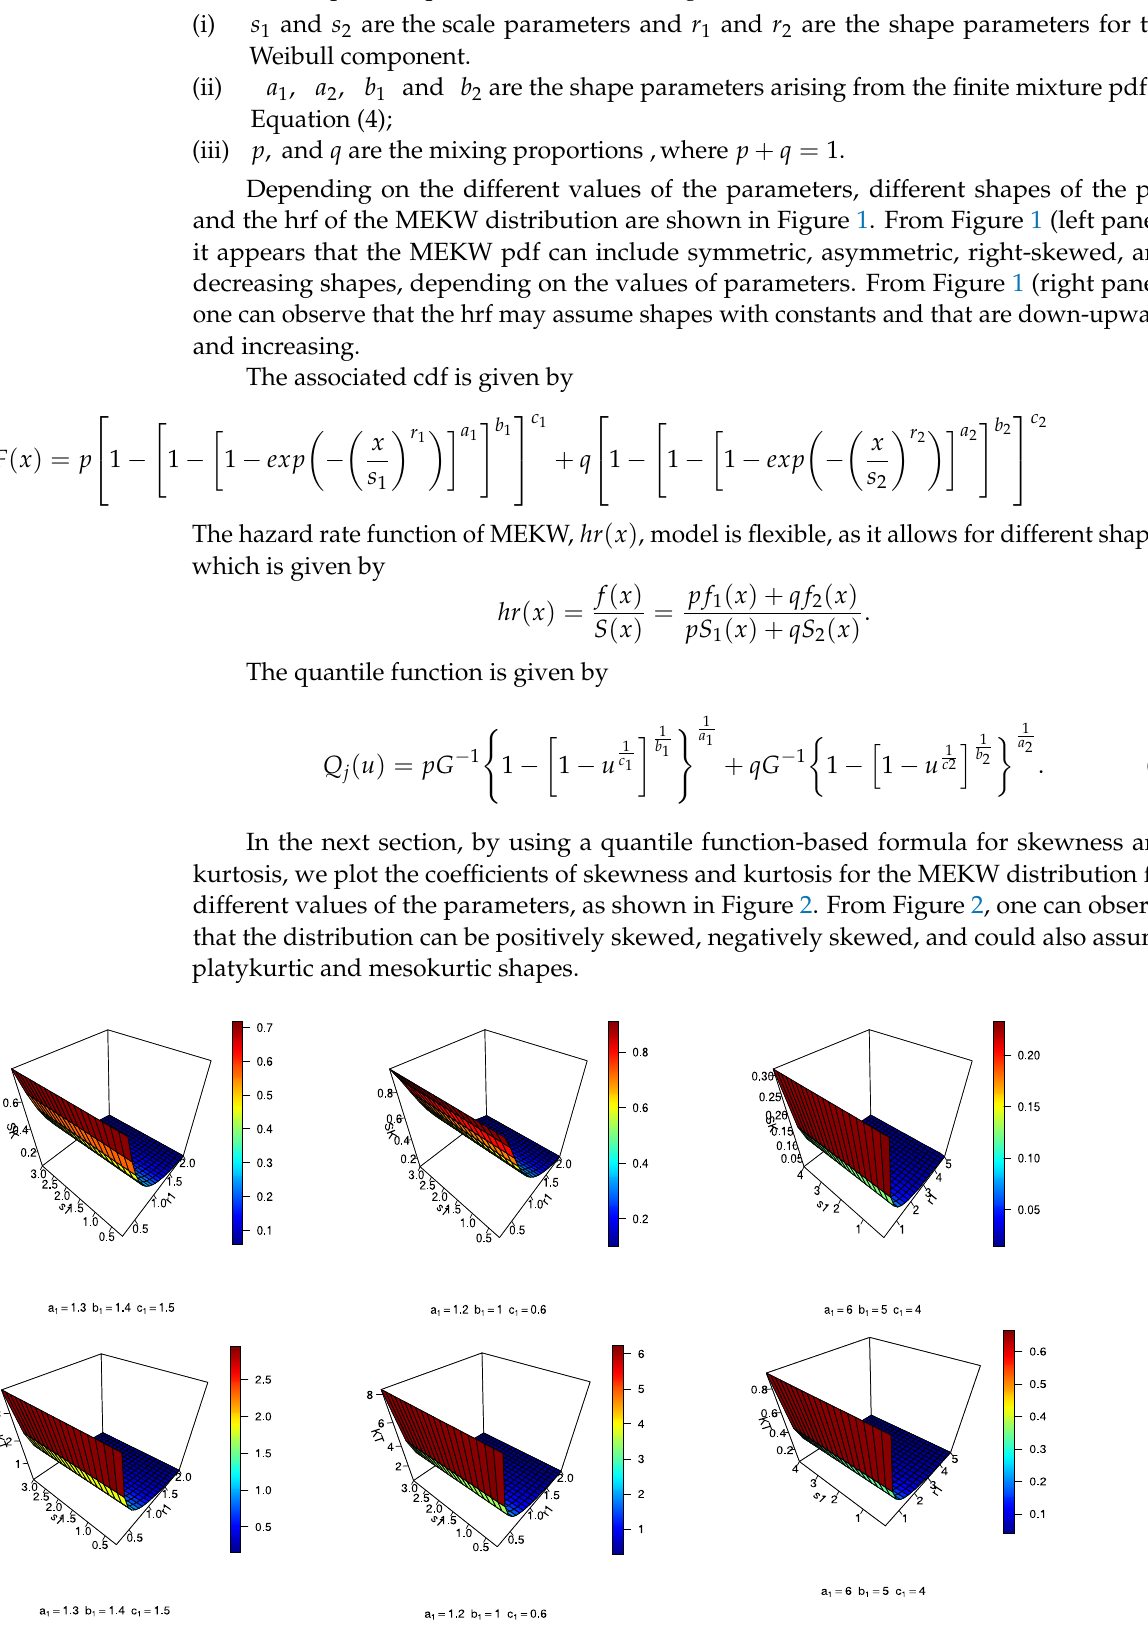
Figure 2. Coefficients of skewness and kurtosis for EKW distribution.